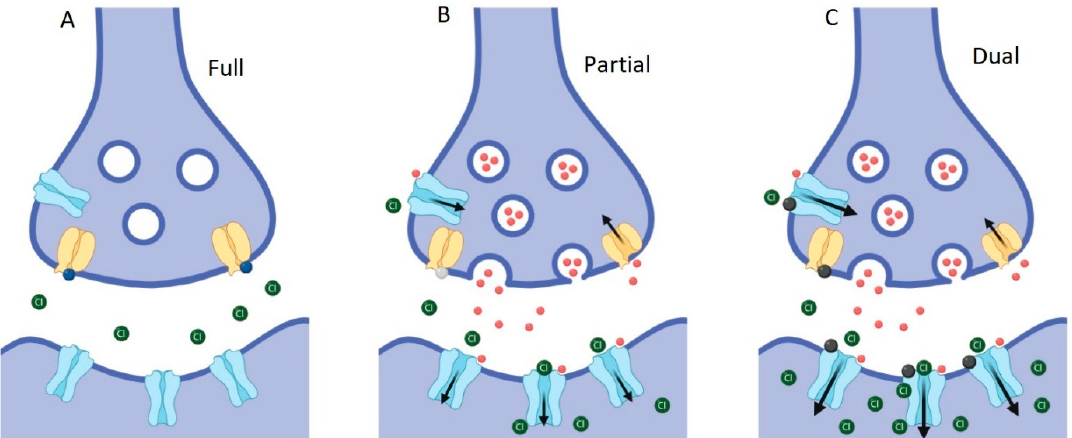
Figure 13. Schematic of inhibitory glycinergic synapse showing effects of modulation at GlyT2 and GlyRs. ( A ) Prolonged complete inhibition of GlyT2 (yellow) leads to steep reductions in presynaptic glycine concentrations, the lack of presynaptic vesicle filling and termination of subsequent glycine release. ( B ) Partial, non-competitive GlyT2 inhibition slows the re-uptake of glycine (red spheres), which will improve the activation of glycine gated GlyRs (blue) while still allowing refilling of vesicles to occur and subsequent glycine release into the synapse to be maintained. ( C ) Partial GlyT2 inhibition and GlyR potentiation by dual-action compounds (black spheres) will increase synaptic glycine concentrations and allow the recycling of glycine through the presynaptic terminal by GlyT2, as in B, while also directly increasing activation of